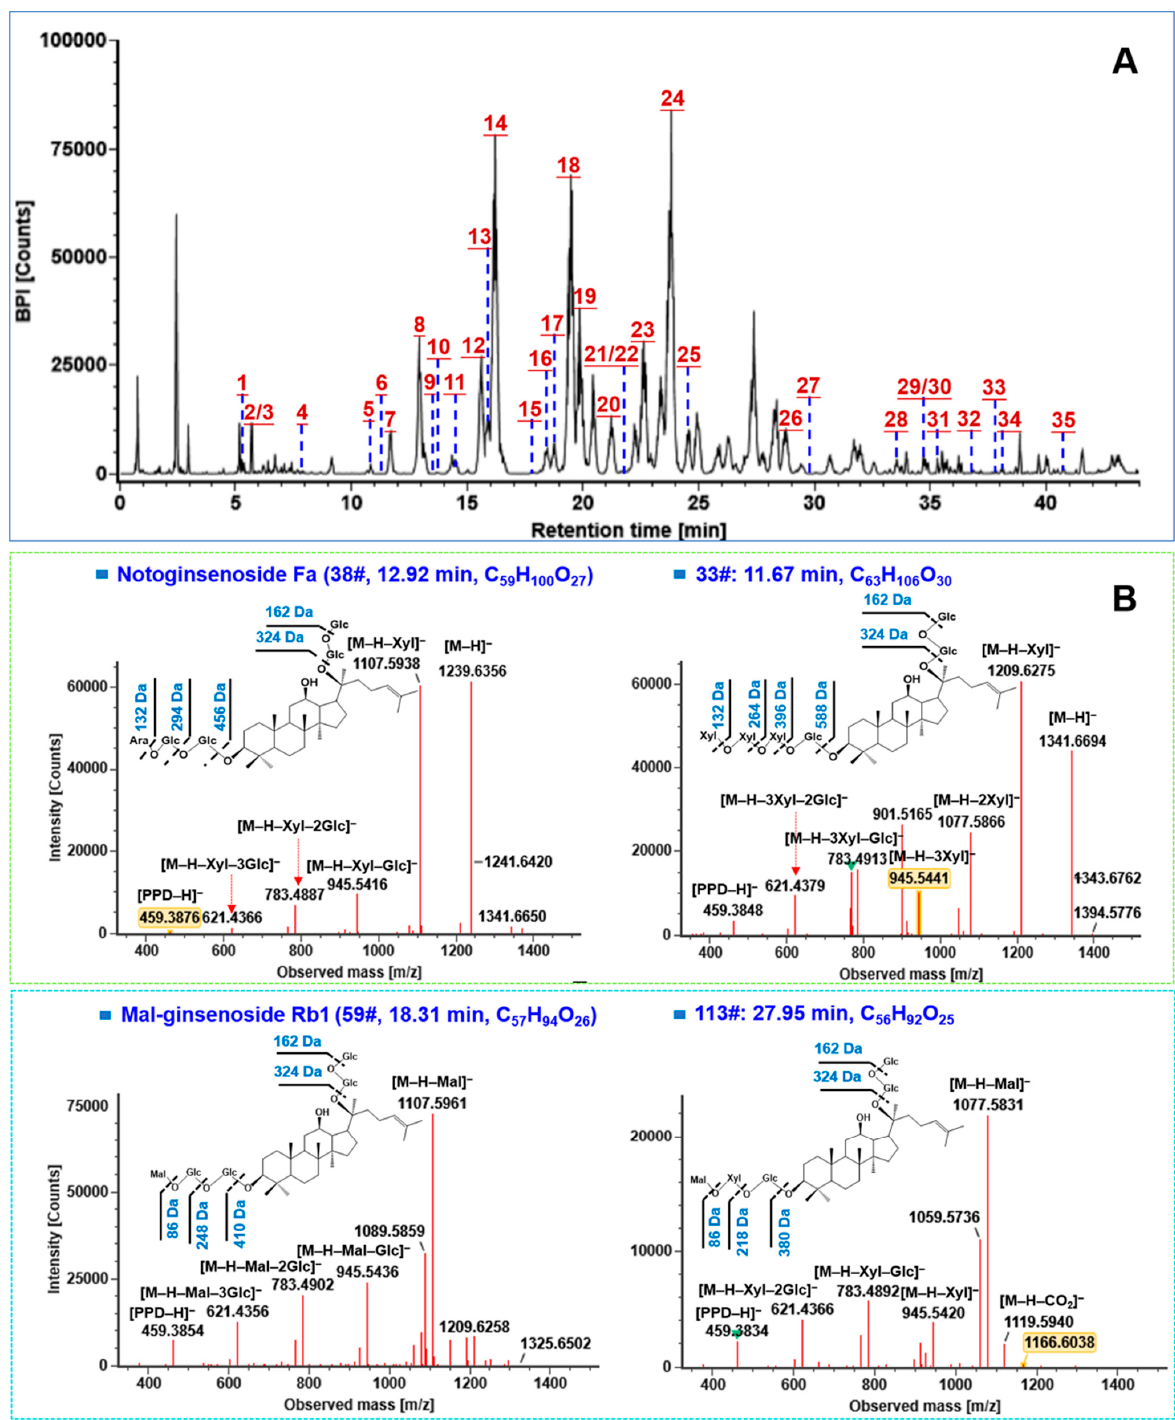
Figure 3. Structural elucidation of ginsenosides from PNF. ( A ) The based peak chromatogram of PNF obtained in the negative ESI mode by UHPLC/IM-QTOF-MS (those identified by comparison with the reference standards are annotated: 1 , noto-R1; 2 / 3 , Rg1/Re; 4 , vina-R4; 5 , noto-R4; 6 , noto-R2; 7 , chiku-L5; 8 , noto-Fa; 9 , Rg2; 10 , Rh1; 11 , F3; 12 , noto-FP2; 13 , noto-Rh1; 14 , Rb1; 15 , Ro; 16 , m-Rb1; 17 , noto-Fc; 18 , Rc; 19 , Ra1; 20 , noto-S; 21 / 22 , F1/m-Rc; 23 , Rb2; 24 , Rb3; 25 , m-Rb2; 26 , Rd; 27 , m-Rd; 28 , gypenoside XVII; 29 / 30 , noto-Fe/noto-Fd; 31 , Rd2; 32 , F2; 33 , Rg3; 34 , 20( R )-Rg3; 35 , Rk1); ( B ) analysis of the CID-MS 2 spectra for the representative ginsenosides of the PPD type and malonylated type.